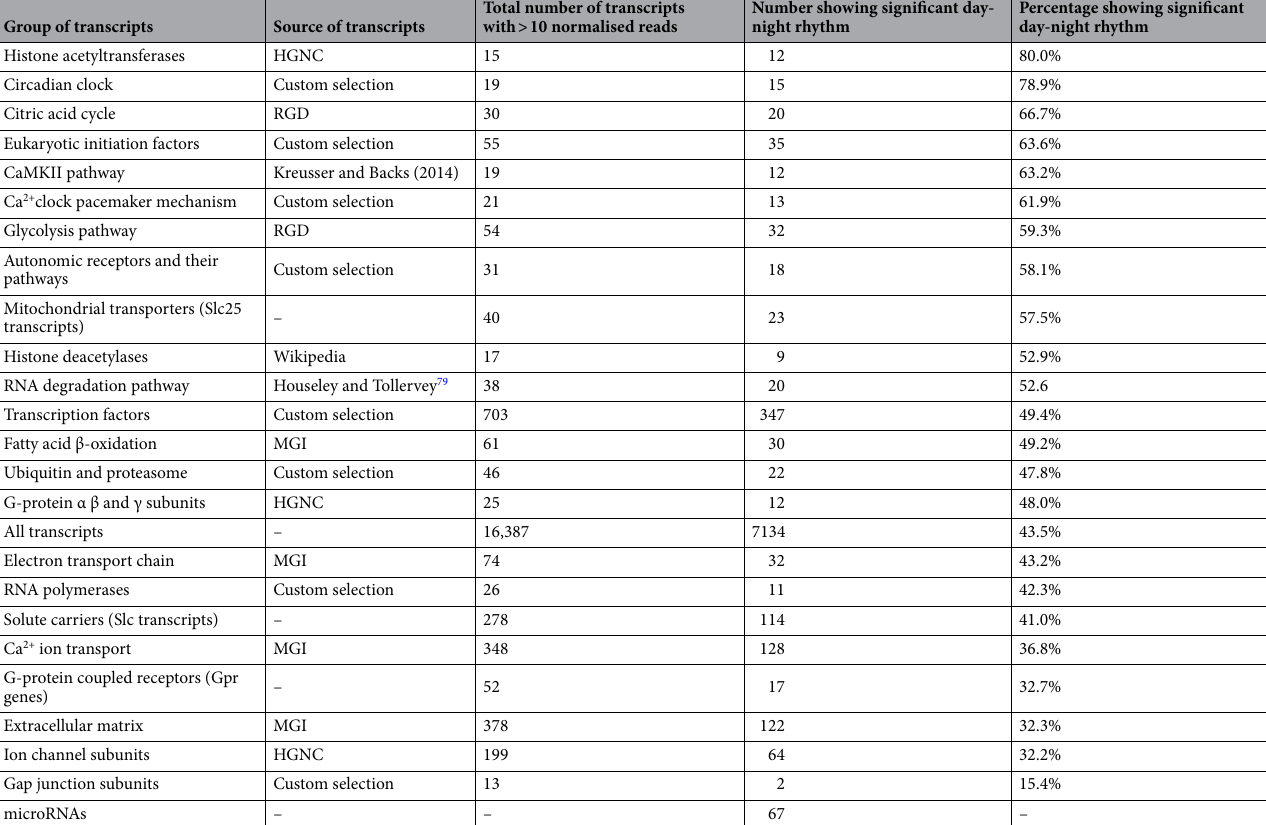
Table 1. Summary of the percentage of transcripts showing a significant day-night rhythm in different groups and pathways. HGNC, HUGO Gene Nomenclature Committee; MGI, MGI Gene Ontology Browser; RGD, Rat Genome